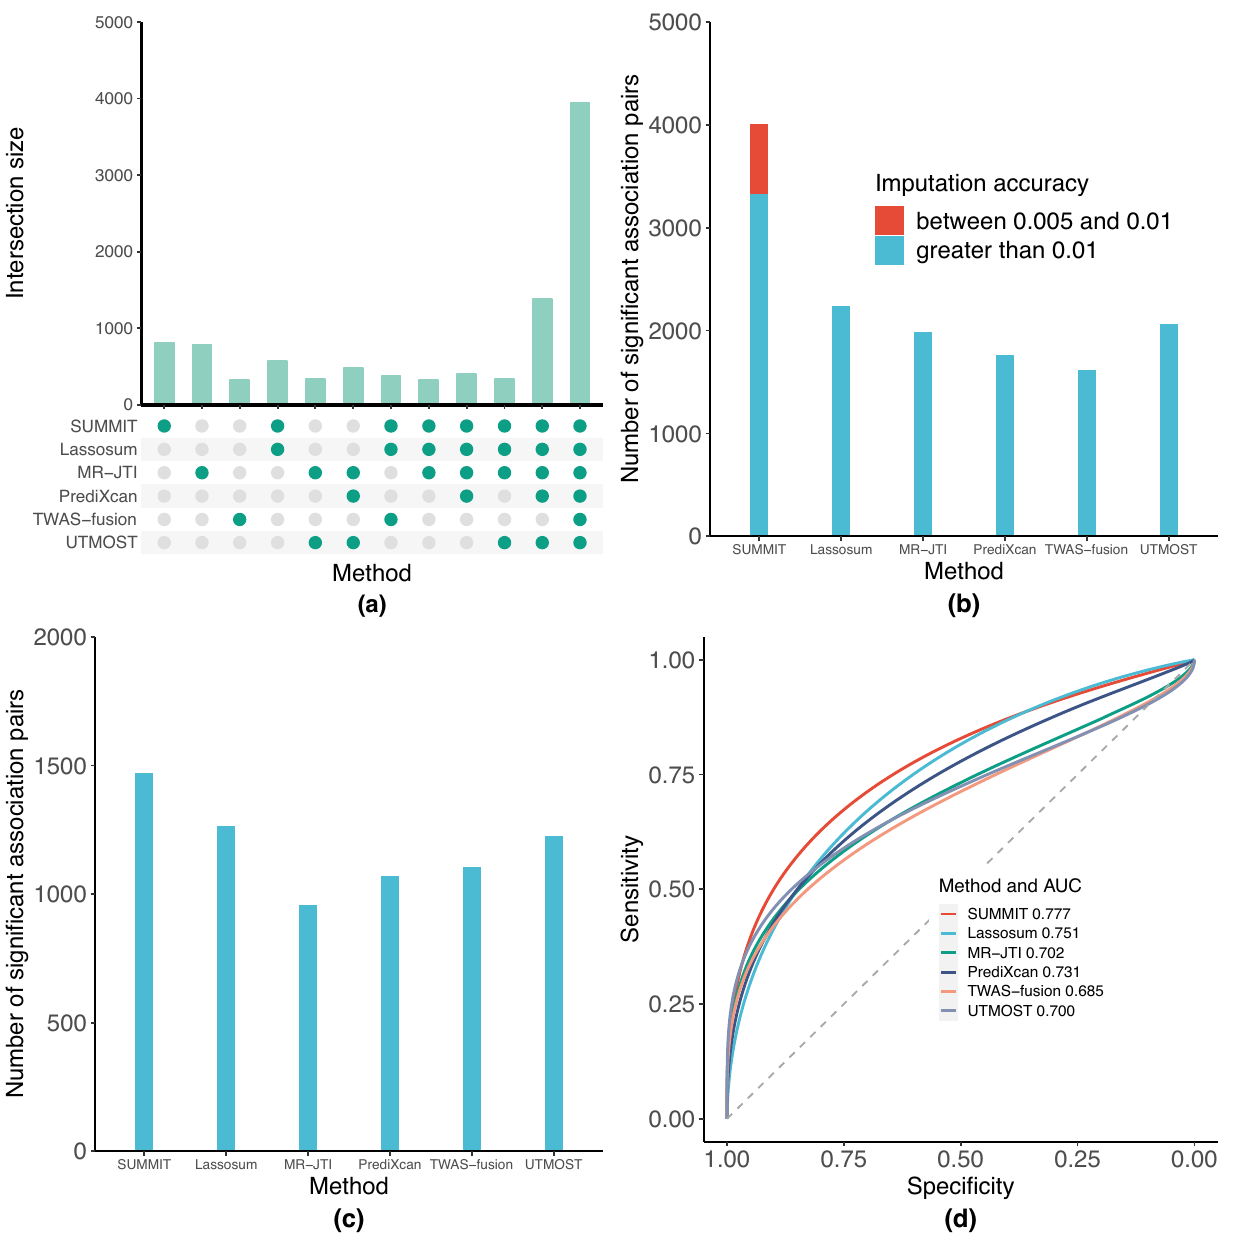
Fig.3|SUMMITimprovestheperformanceofTWASsonrealdata.a IstheUpSet plot of overlapping imputation models with R 2 ≥ 0.01 among different methods. b Shows the numbers of associated genes identi fi ed by different methods when